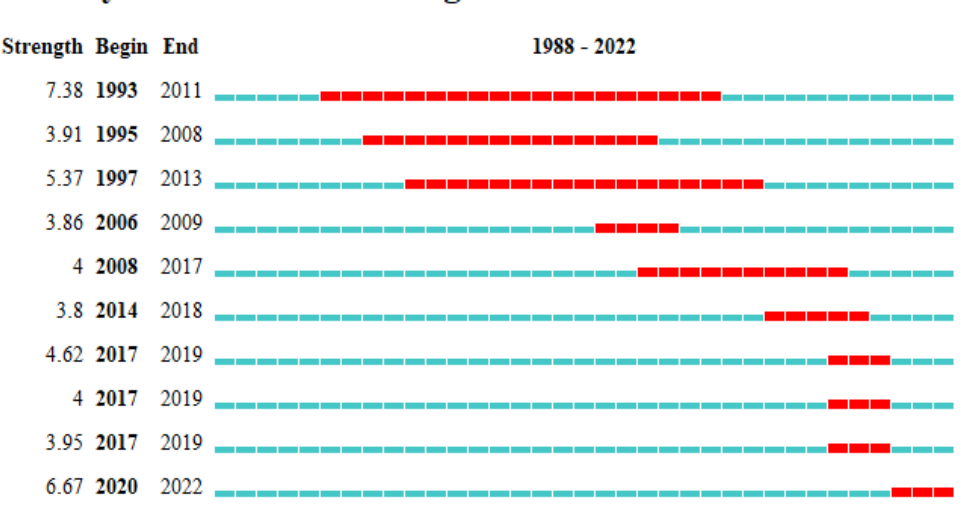
Figure 9. Keywords co-occurrence network from a timezone view.